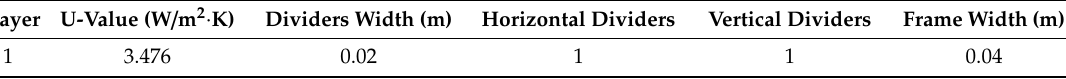
Table 5. Frame and